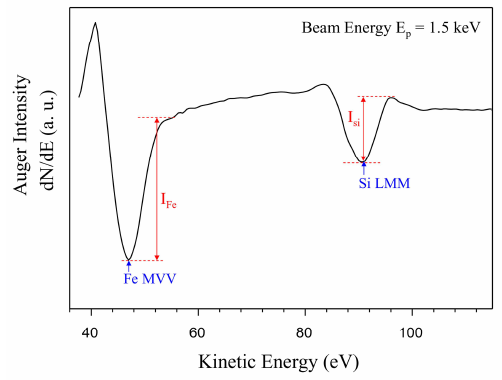
Figure 4. Auger electron spectroscopy (AES) of the Fe-silicide NWs on Si(110).